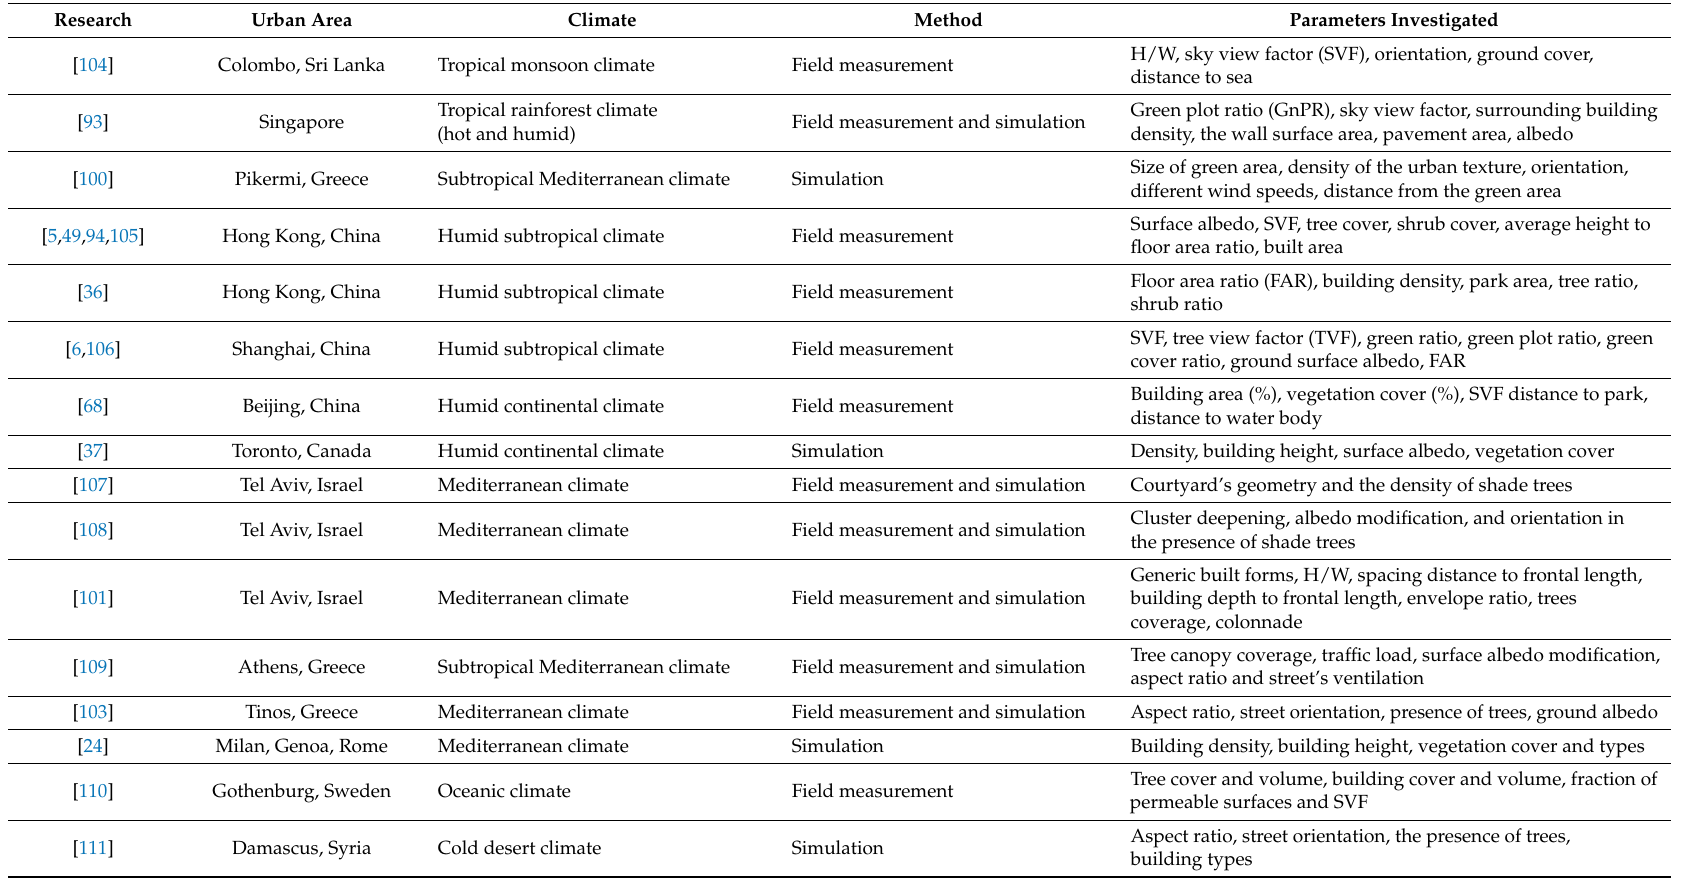
Table 1. Literature on the combined effect of urban geometry and